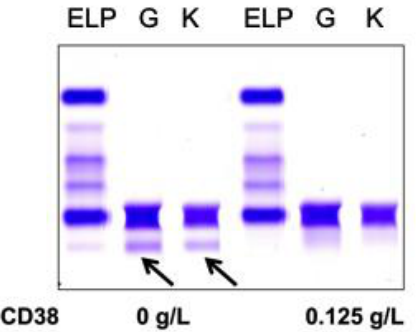
Figure 5. A representative patient sample is shown for illustration of the impact of pre-treatment and efficiency of recombinant biotinylated CD38 tested in sera from patients with PCM (IgG kappa indicated by arrows) who were receiving DARA as a therapy. CD38 ligand antibody completely removed the IgG kappa band associated with DARA.